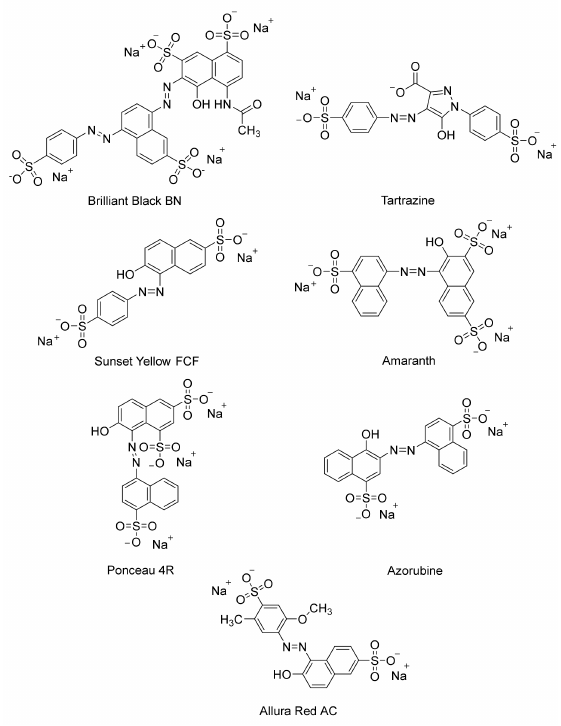
Figure 1. Commonly used azo dyes in the food